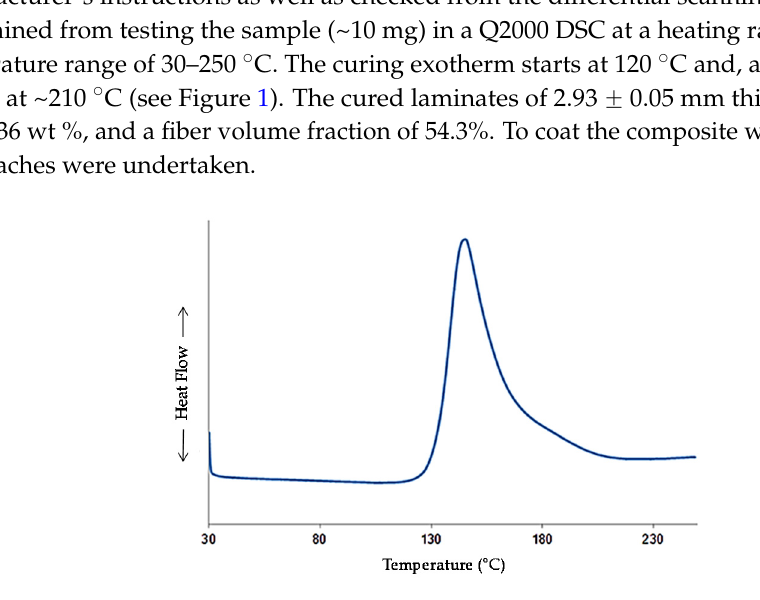
Figure 1. Differential scanning calorimetric (DSC) curve of UMECO MTM ‐ 45 ‐ 1 prepregs.